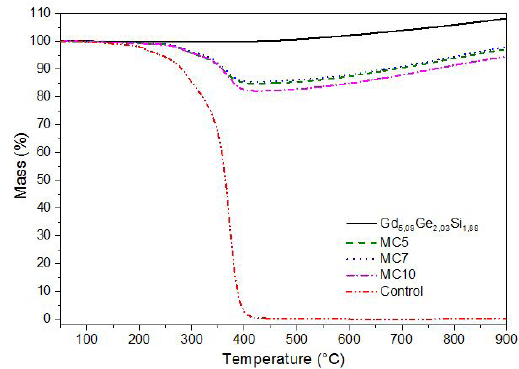
Ge Si powder, 5.09 2.03 1.88